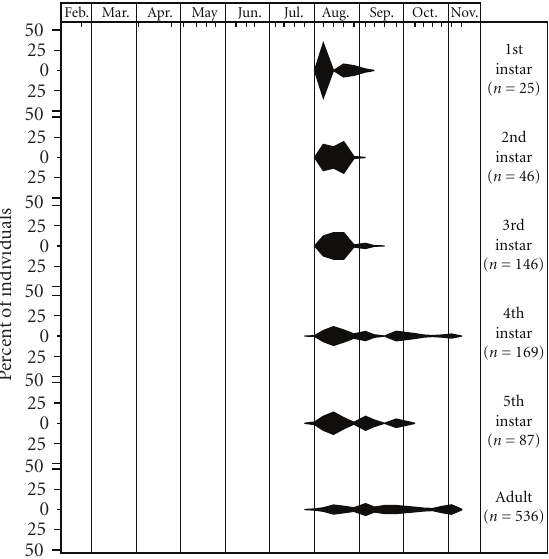
Figure 4: Percent of individuals of Rhagovelia oriander of same stage across all sample dates.